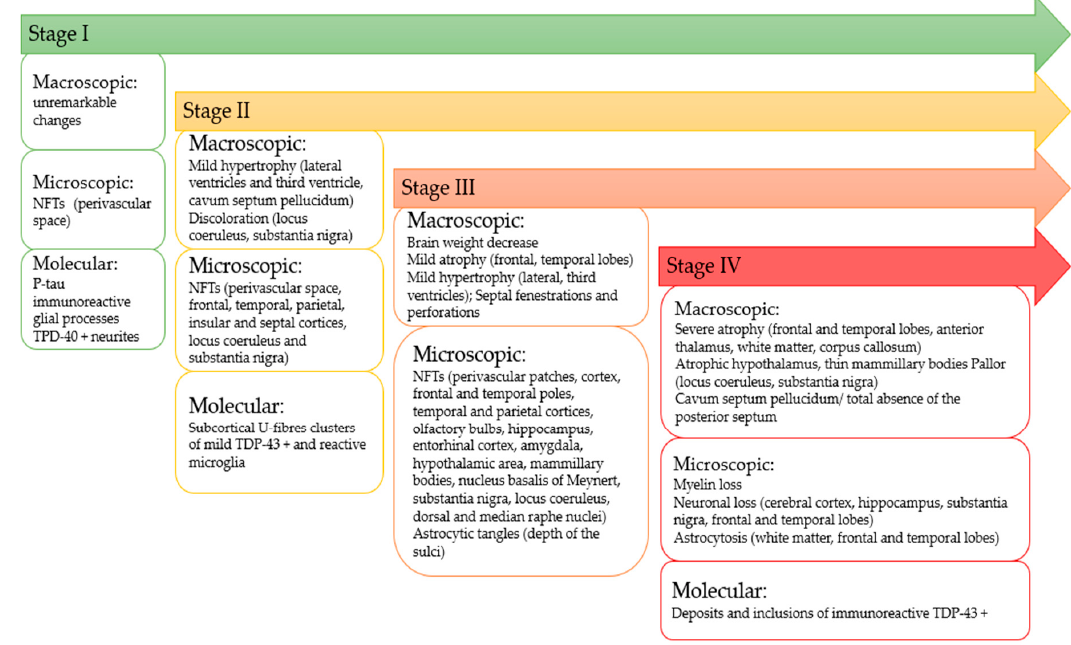
Figure 1. Timeline of CTE